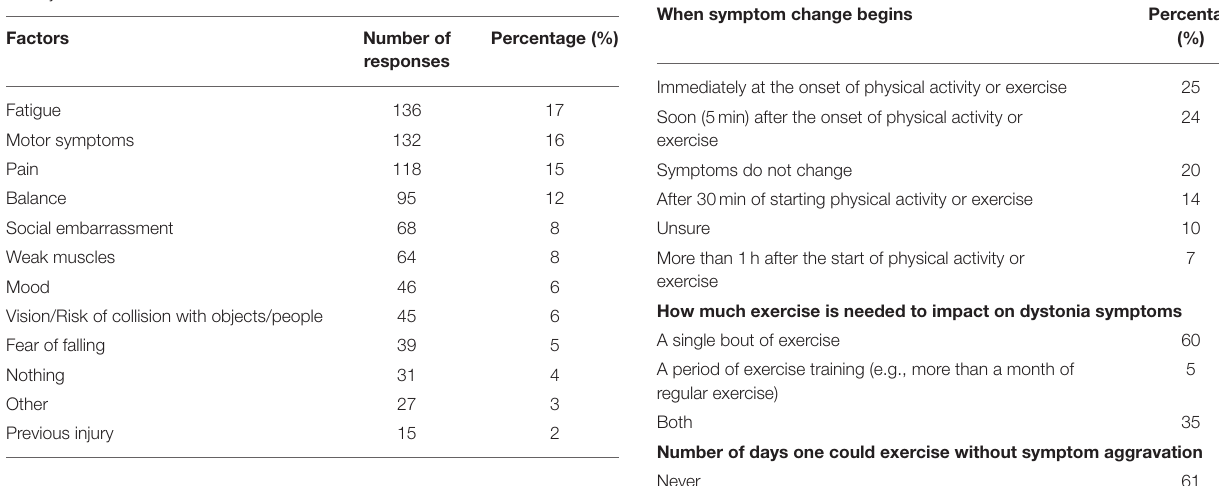
TABLE 3 | Reasons that prevent people with dystonia from engaging in physical activity and exercise.